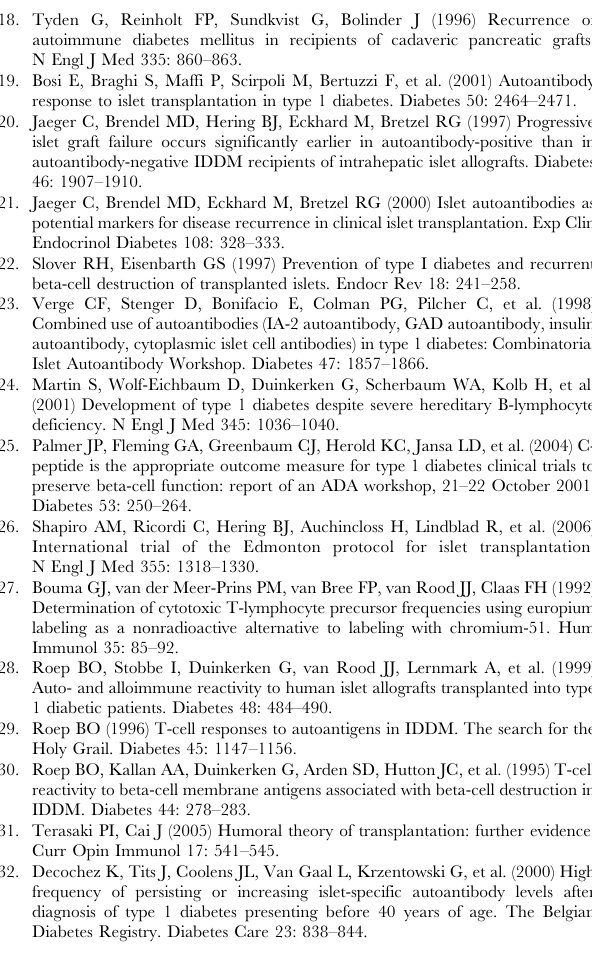
Table S1 Characteristics of immune reactivity and clinical parameters per patient.